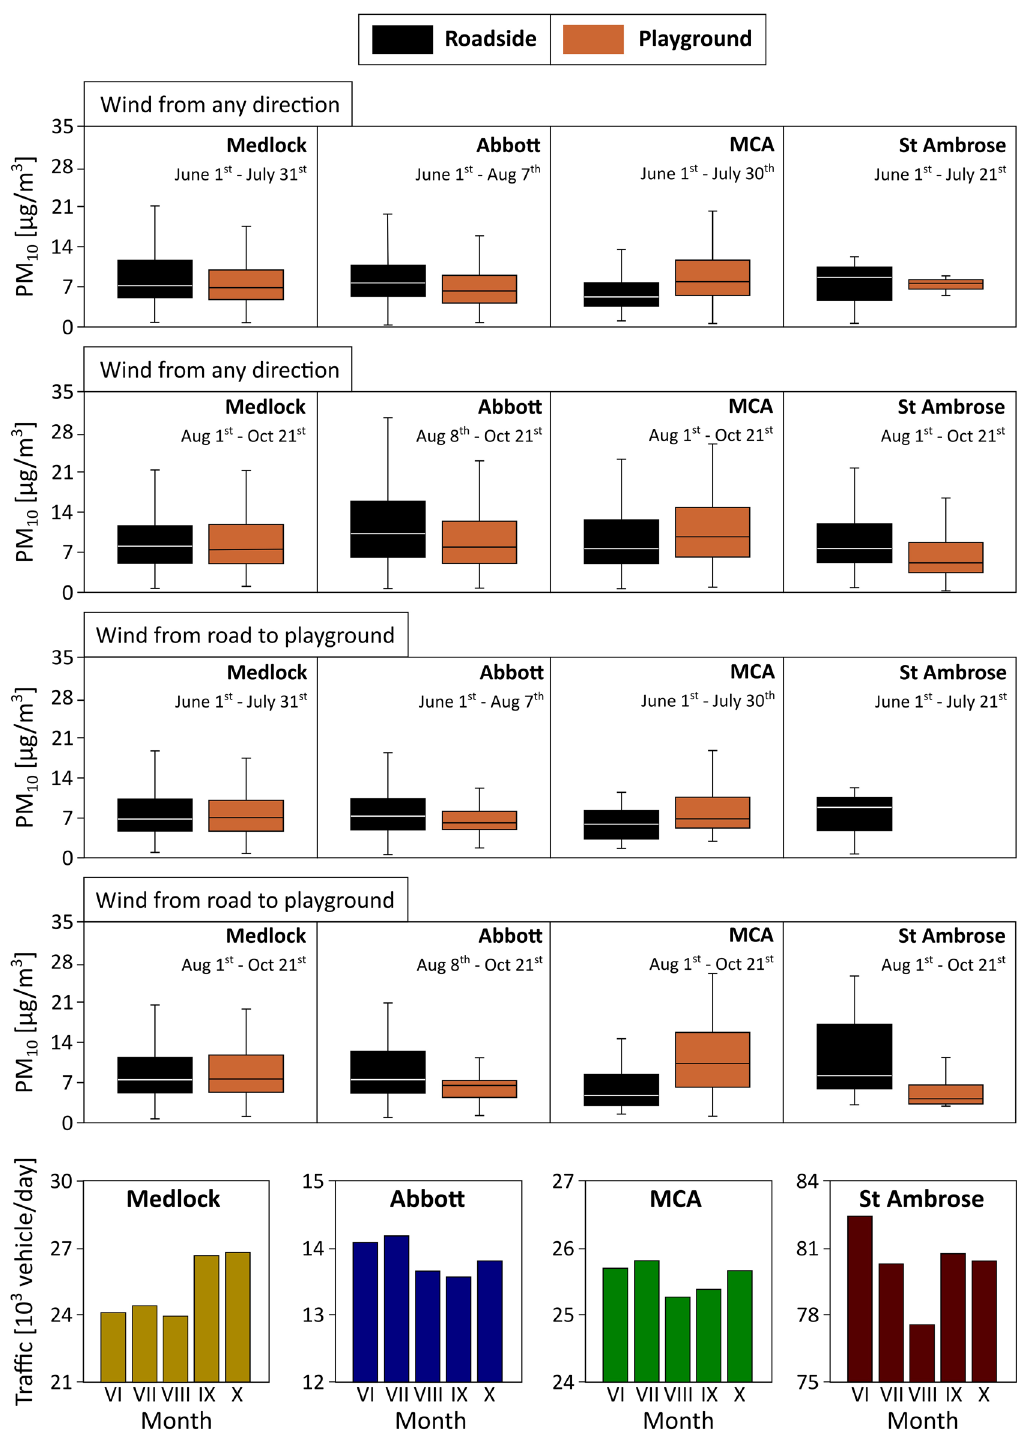
Figure 2. PM 10 concentrations (hourly average) for summer (pre-tredge installations) and late summer/ autumn, 2019 at the roadside and at distal playground (14–17 m from roadside for Medlock, Abbott and St Ambrose, 7 m for MCA), and the road traffic volume for the 4 schools. In the box-whisker plots, boxes indicate median value, lower and upper quartiles, and whiskers show 10th and 90th percentiles. The absence of data (St Ambrose summer) reflects sensor